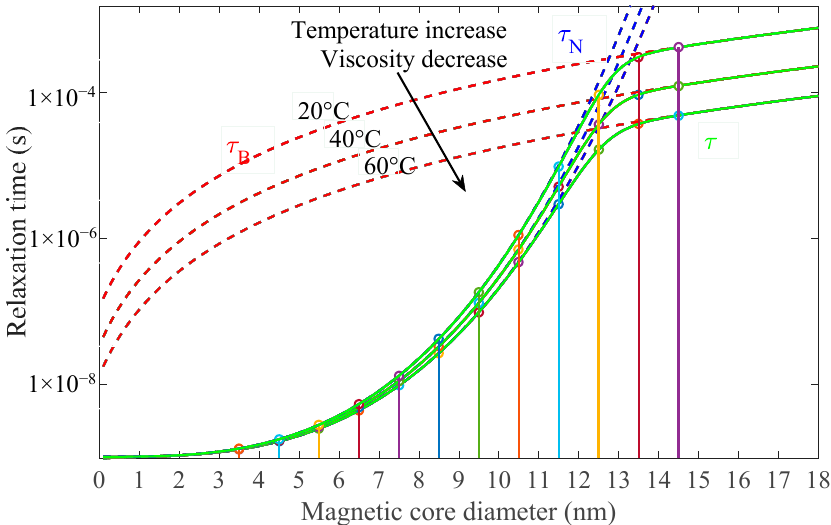
Figure 4. Calculated relaxation times for different magnetic core sizes for three temperatures and viscosities.